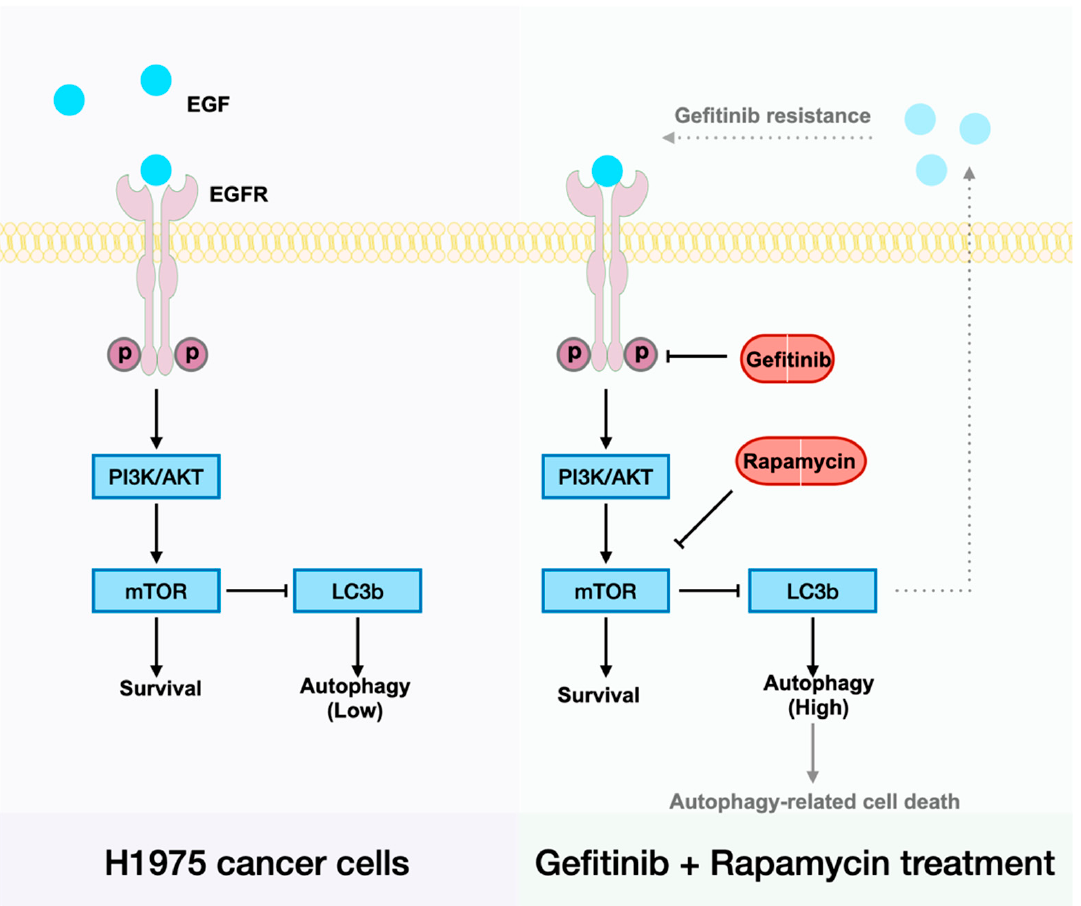
Figure 5. Schematic illustration of the cellular mechanism of drug combination therapy in gefitinib- resistant cells. Dotted lines and translucent words/figures denote points that have not yet been val- idated.